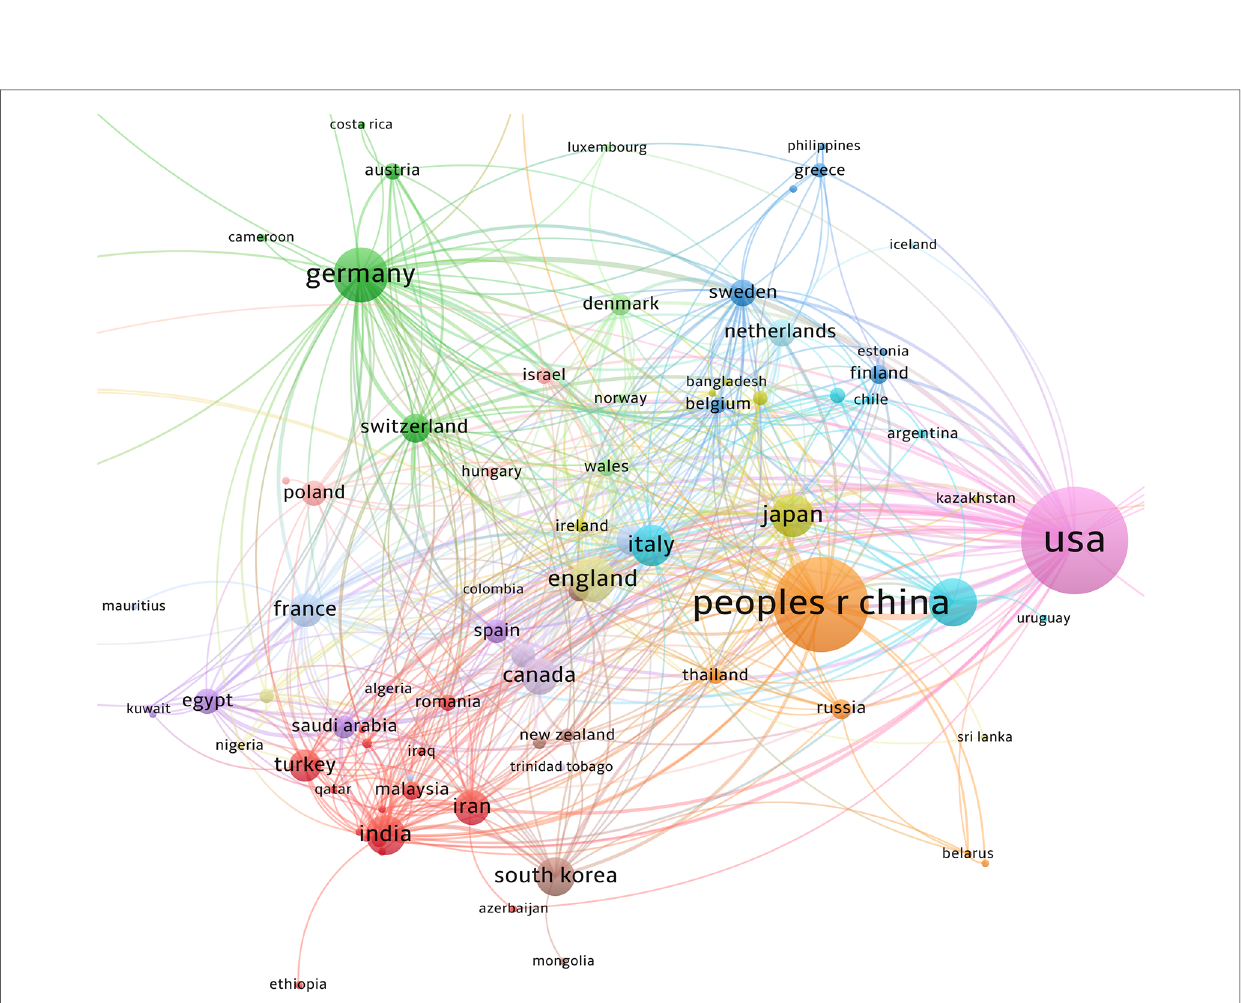
FIGURE 3 The co-authorship network of countries/regions. A total of 99 countries/regions have participated in the study. China and the United States are the centers of the study. The largest cluster is centered on the United States. China ’ s cooperation between countries and regions is relatively